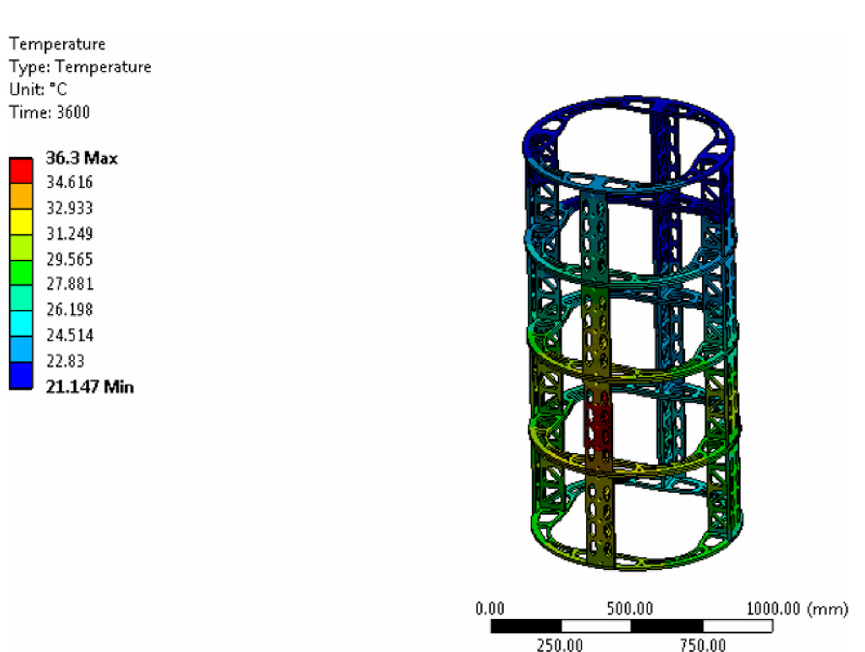
Fig. 6. Transient thermal